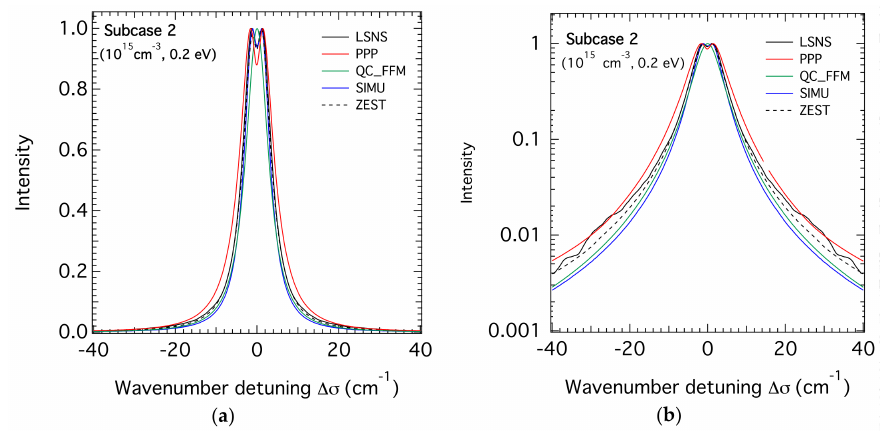
Figure 2. The same as Figure 1 but T e = T i = 0.2 eV. The same line styles and code colors as are used as Figure 1. ( a ) linear scale; ( b ) semi-logarithmic scale.